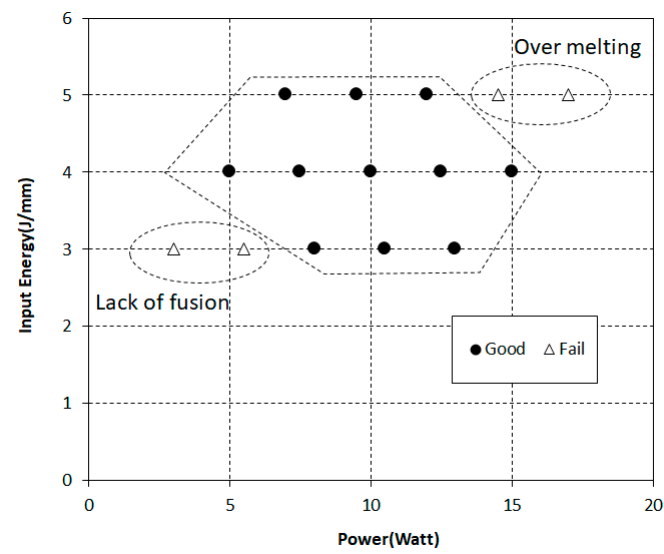
Figure 6. Results of the welding evaluated by visual inspection.